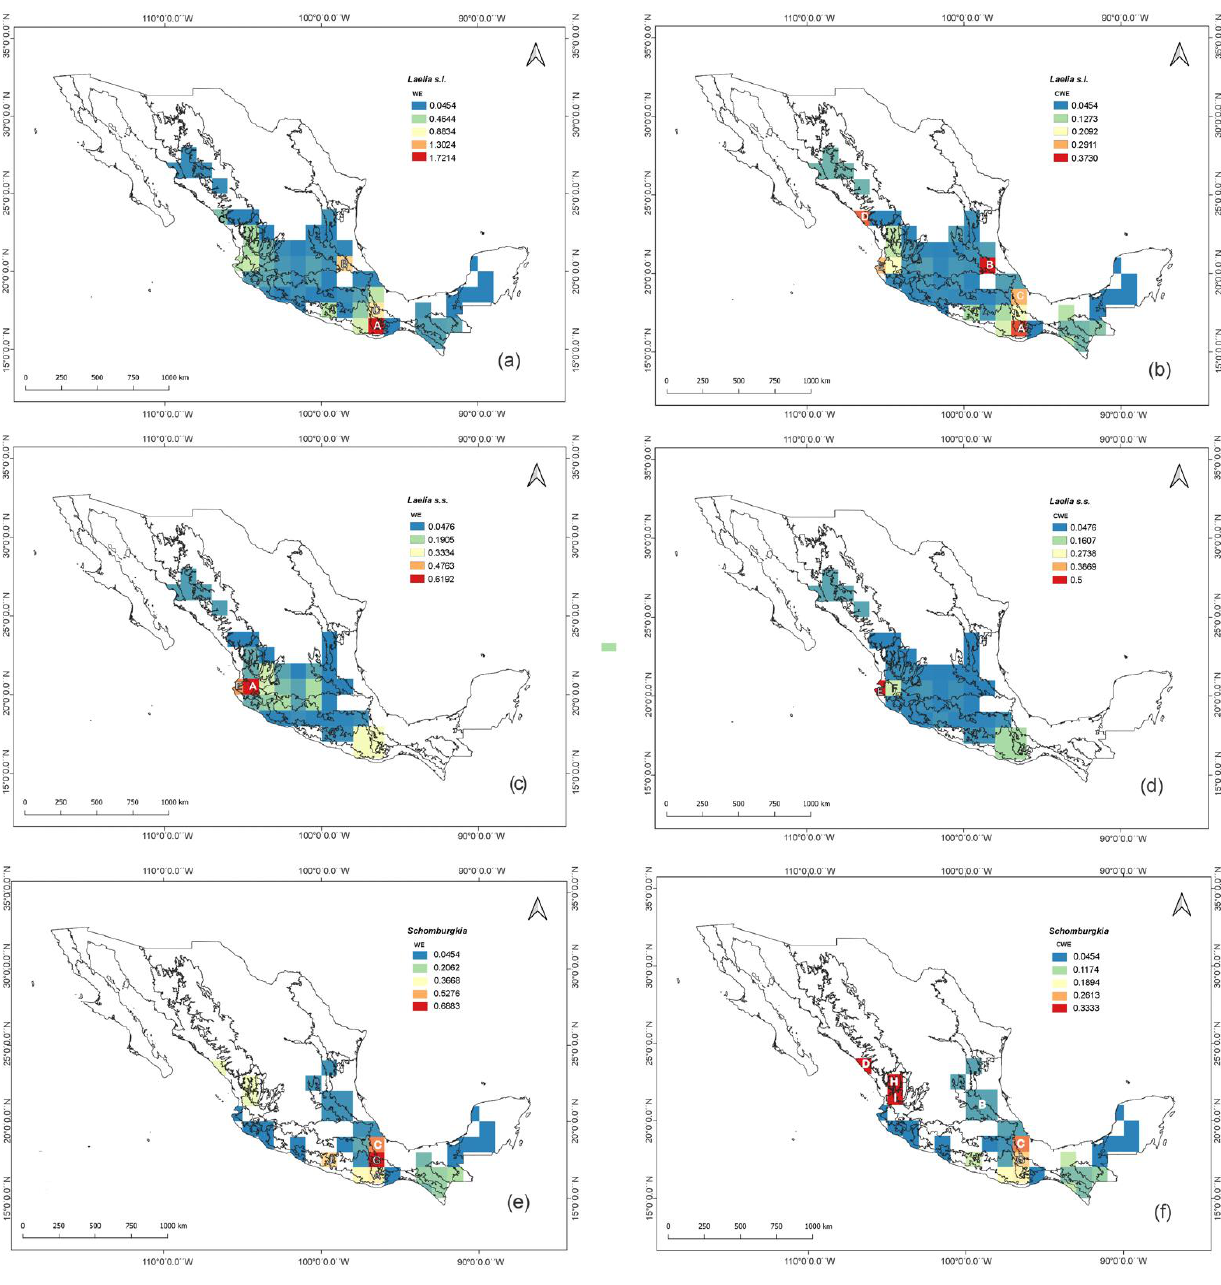
Figure 5. Weighted endemism index (WE) values for ( a ) Laelia s.l., ( c ) Laelia s.s., and ( e ) Schomburgkia and corrected weighted index (CWE) values for ( b ) Laelia s.l., ( d ) Laelia s.s., and ( f ) Schomburgkia